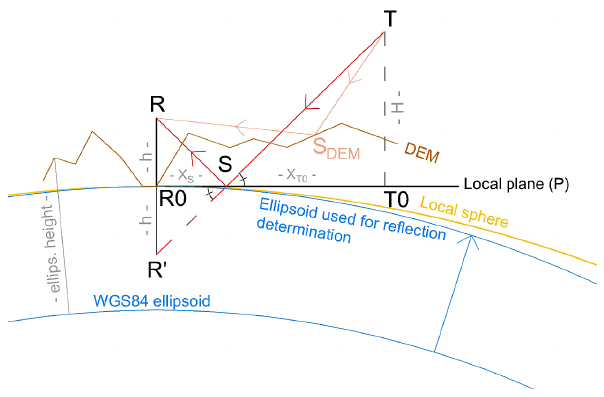
Figure 3. Determination of the specular reflection point in a local plane approximation and local difference with the sphere and el- lipsoid approximations and DEM integration. S : specular reflection point position. R : receiver position. T : transmitter/satellite position. h : height of the receiver above the ground